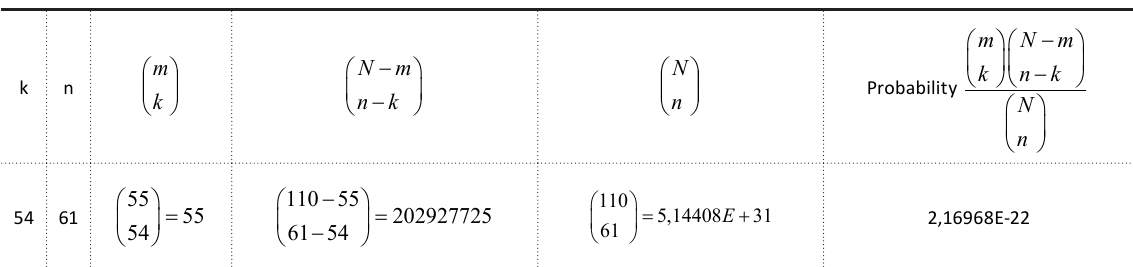
Table 1. Exact test – hypergeometric distribution – hypothesis No. 1 (option 50:50), for N = 110, m = N /2 = 110/2 = 55